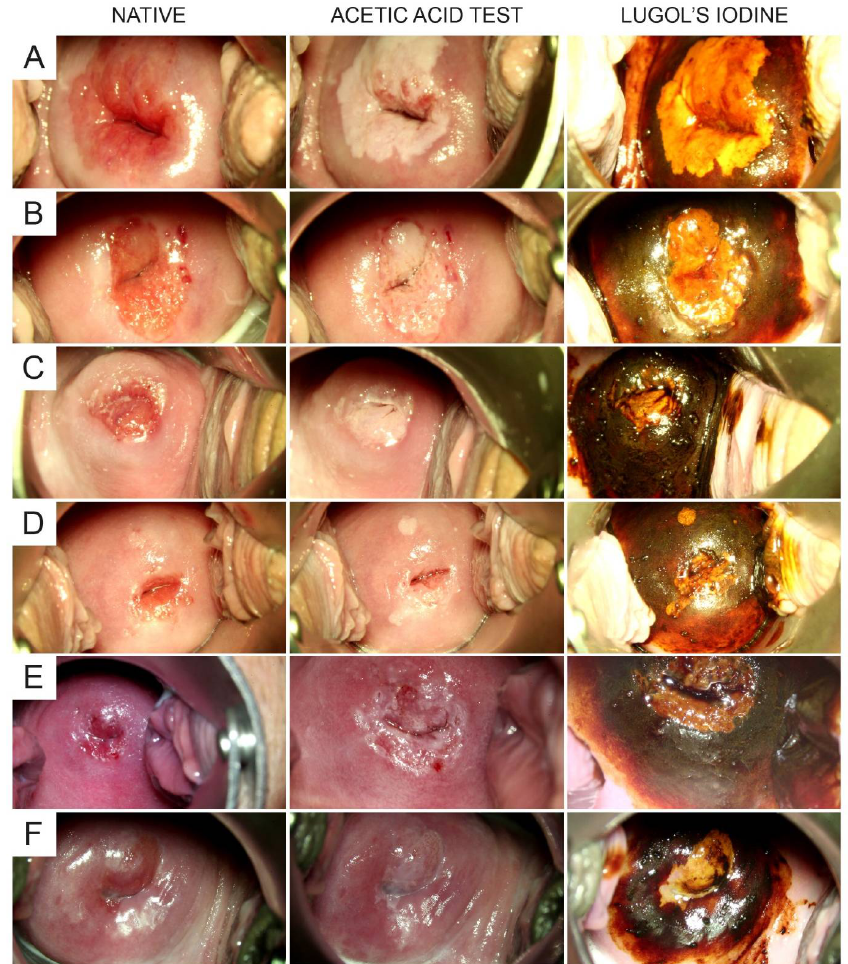
Figure 2. Video stills showing in each row the native cervix (left column), the cervix approx. 1 min after the application of acetic acid (middle column), and the cervix within 10 s after the application of Lugol’s iodine (right column), respectively. Each row ( A – F ) represents a different patient.